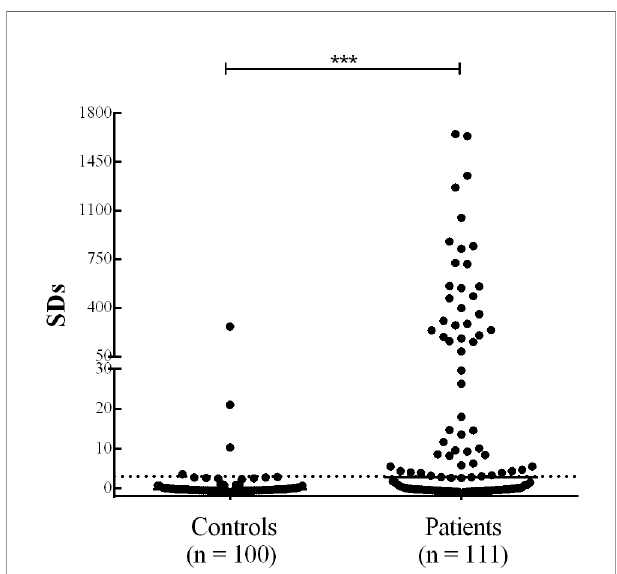
FIGURE 4 | PAA results obtained by FloCMIA in sera from normal control individuals and sera from type 1 diabetic patients. Results are expressed as SDs. The cut-off value (SDs >3.0) is indicated by a dotted line and medians for each population are indicated as a full line (***p < 0.0001).